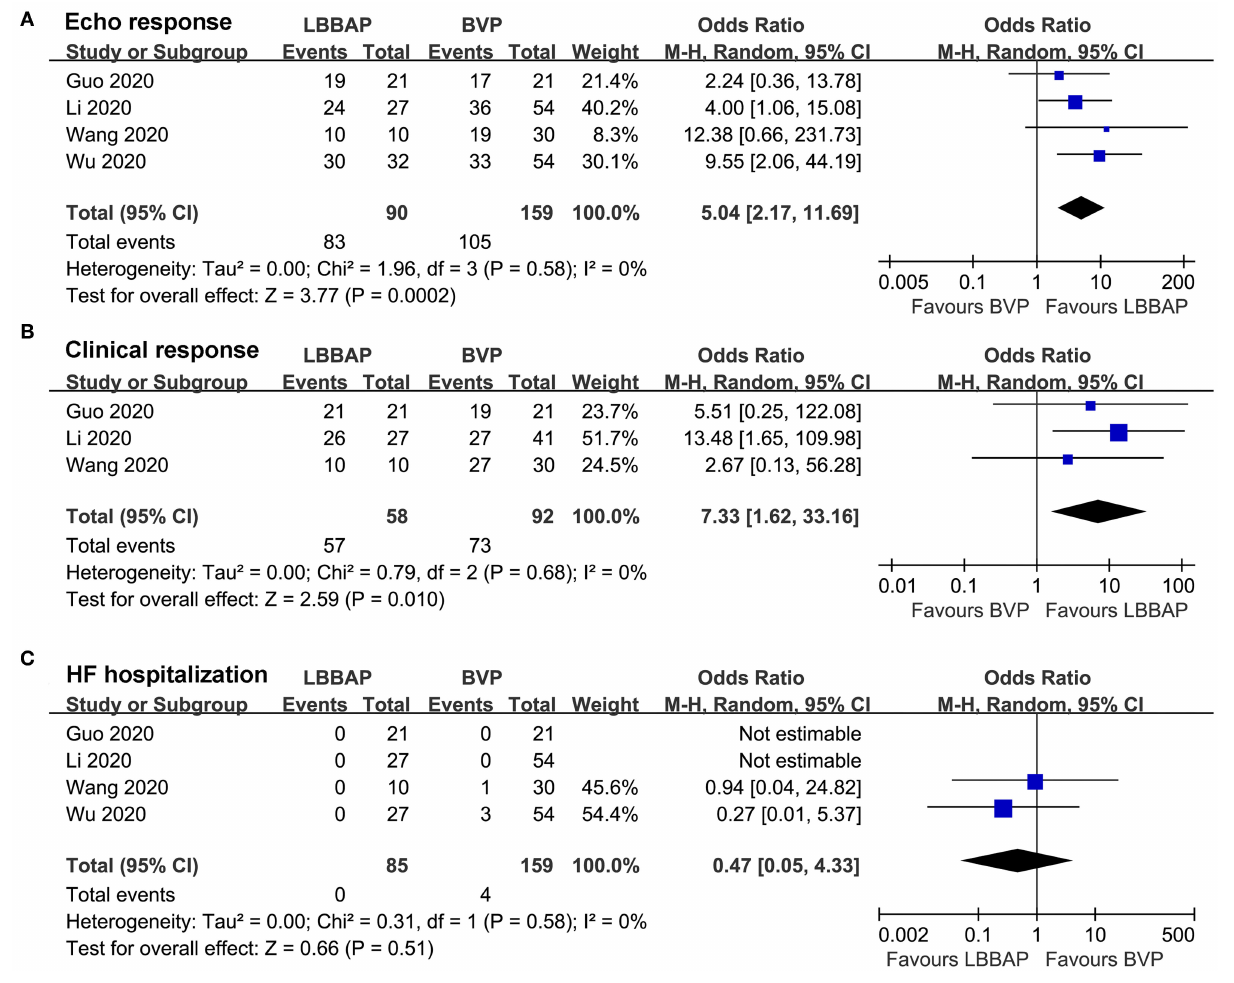
FIGURE 3 | Forest plots for the meta-analysis comparing influences of LBBAP and BVP on CRT response rates and incidence of adverse events during follow-up. (A) echocardiographic response, (B) clinical response, and (C) HF